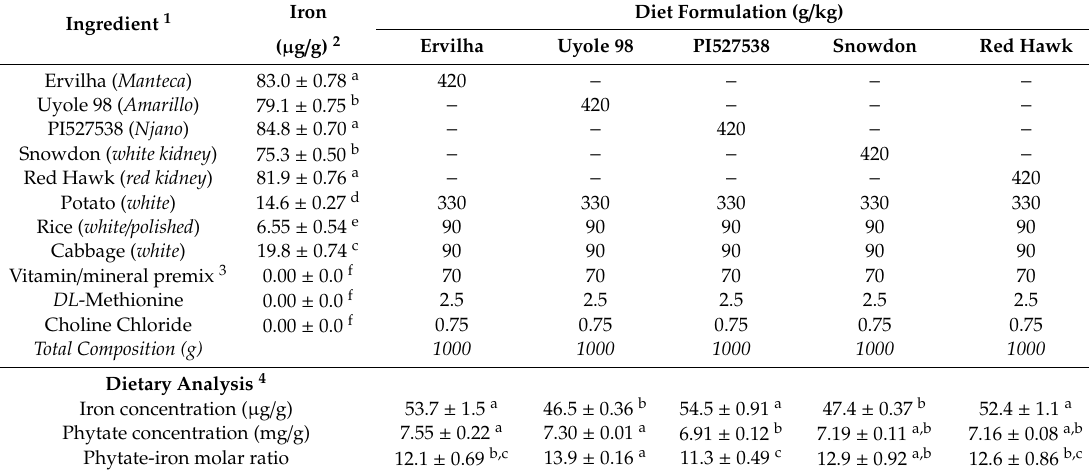
Table 2. Ingredient Formulation, Iron Concentrations and Phytate Analysis of Bean Based